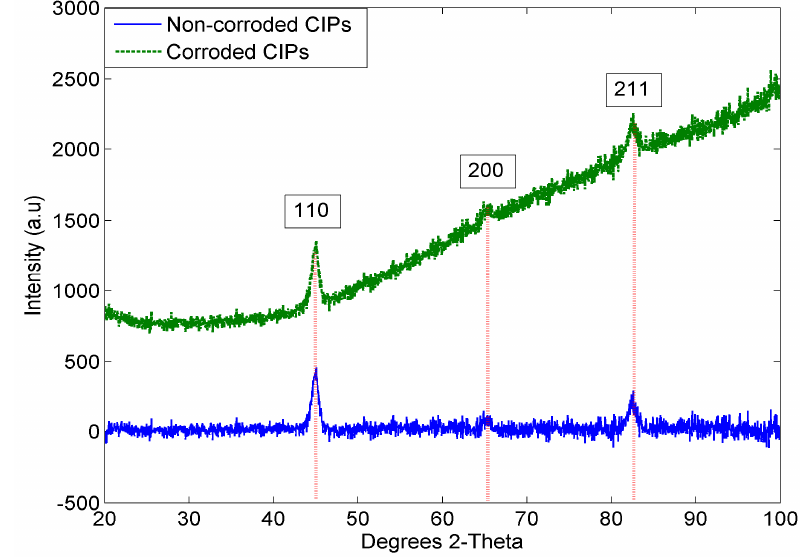
Figure 3. XRD patterns for corroded and non-corroded CIPs.